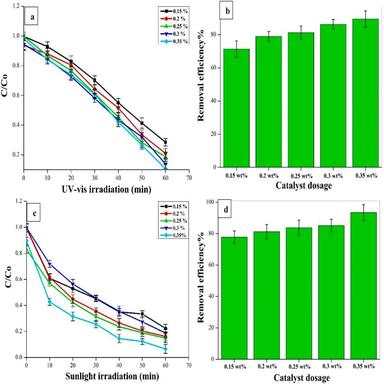
Effect of different catalyst dosage and catalyst efficiency (a,b) UV–vis irradiation, (c,d) Sunlight irradiation.